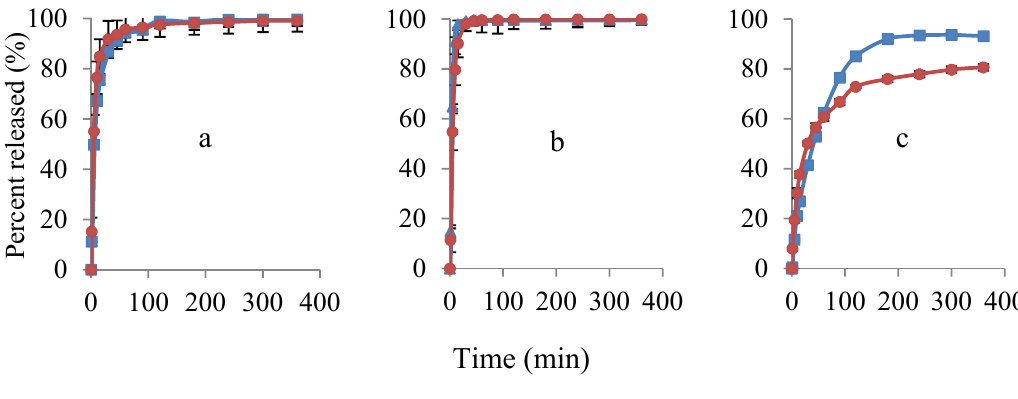
Figure 6. Release profiles of propranolol hydrochloride from porous filter paper substrates with UV ( ■ ) and potentiometric method ( ● ). Ratios of EC:HPC in the polymer